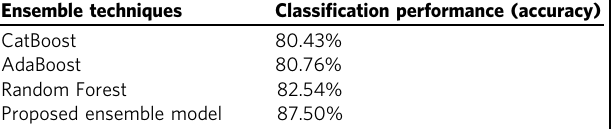
Table 8 Comparison of classi fi cation performance of proposed soft voting ensemble model with classical ensemble